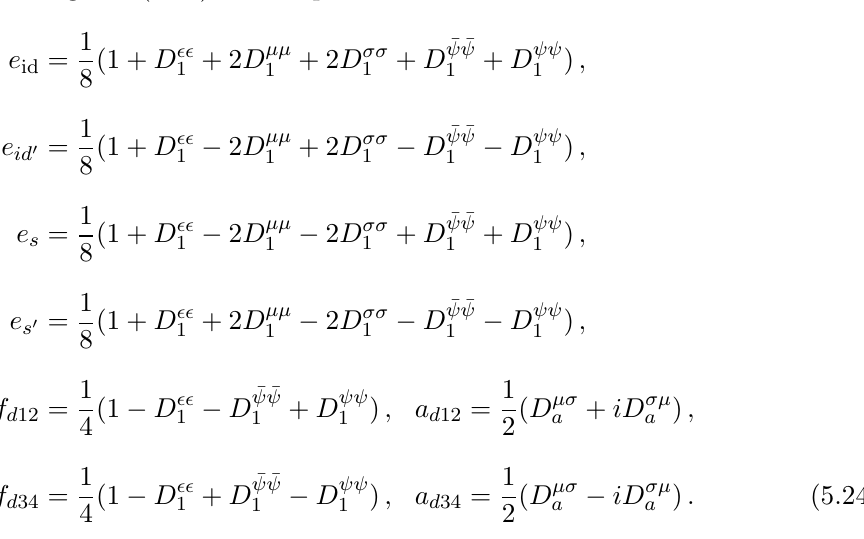
Table 8 . Solutions for the bulk-defect structure constants in the fermionic Ising model. satisfying the same algebra (3.13). The explicit forms